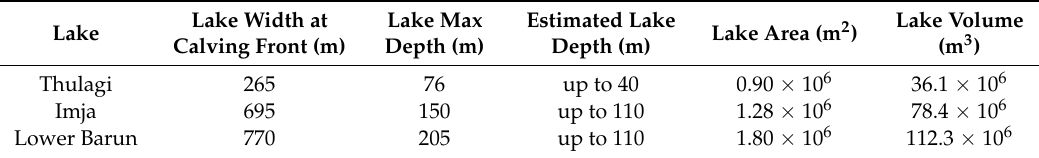
Table 1. Some critical lake properties relevant to